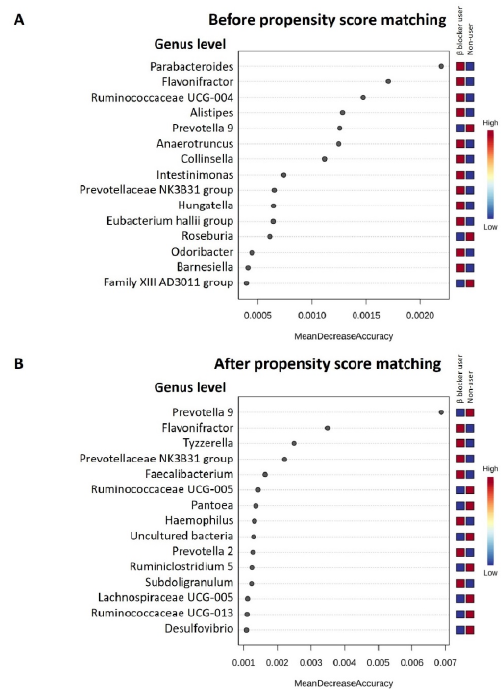
Figure 4. Determination of specific bacteria for discriminatory across hemodialysis patients with and without β blocker treatment in full cohort ( A ) and propensity score matching cohort ( B ). The discrim- inatory taxa were determined by applying Random Forest analysis using the genus-level